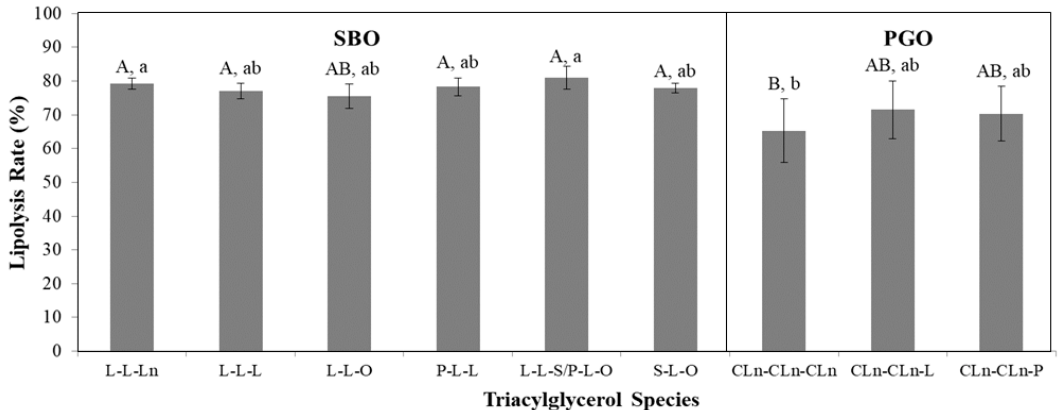
Figure 4. Lipolysis rates (%) of individual triacylglycerol (TAG) species in soybean oil (SBO) and pomegranate seed oil (PGO) after 30 min of digestion in the simulated model of small intestinal digestion. Statistical differences are indicated by letters where significant differences were detected ( p < 0.1 for A and B; p < 0.05 for a and b). Abbreviation: P, palmitic acid; S, stearic acid; O, oleic acid; L, linoleic acid; Ln, linolenic acid; CLn, conjugated linolenic acid.